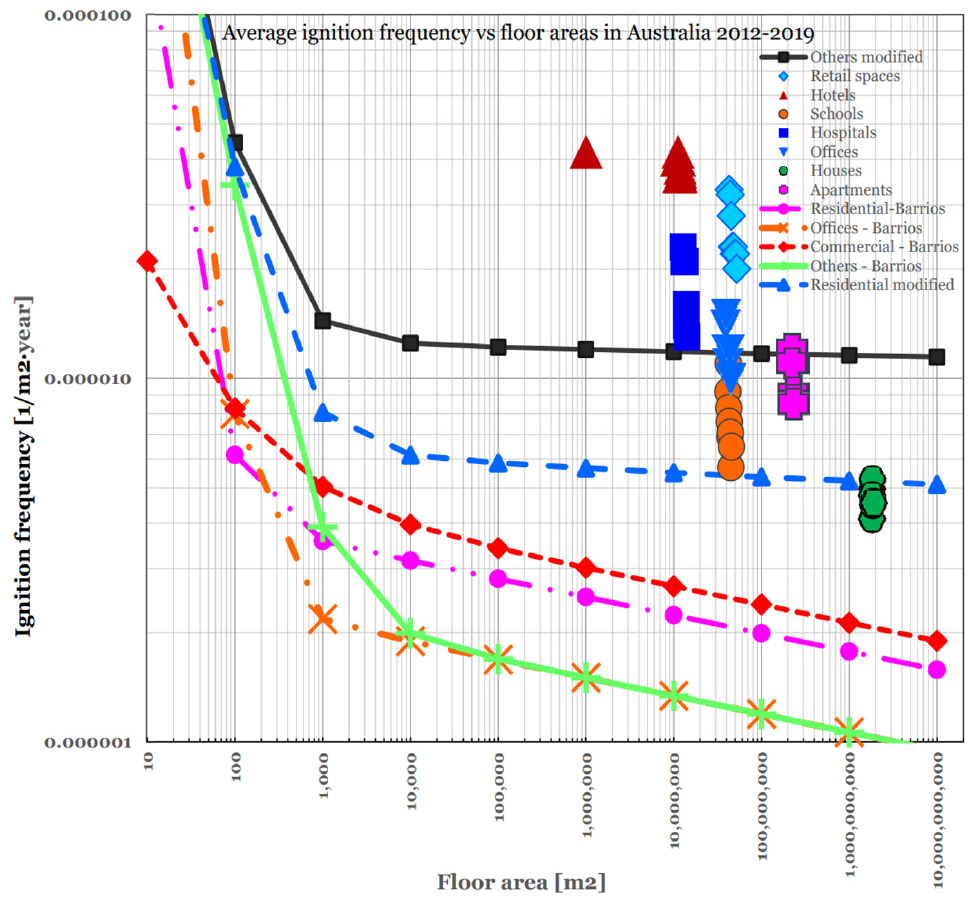
Figure 11. Comparison of the statistical ignition frequency in hotels in Australia with generalized and improved Barrois models.